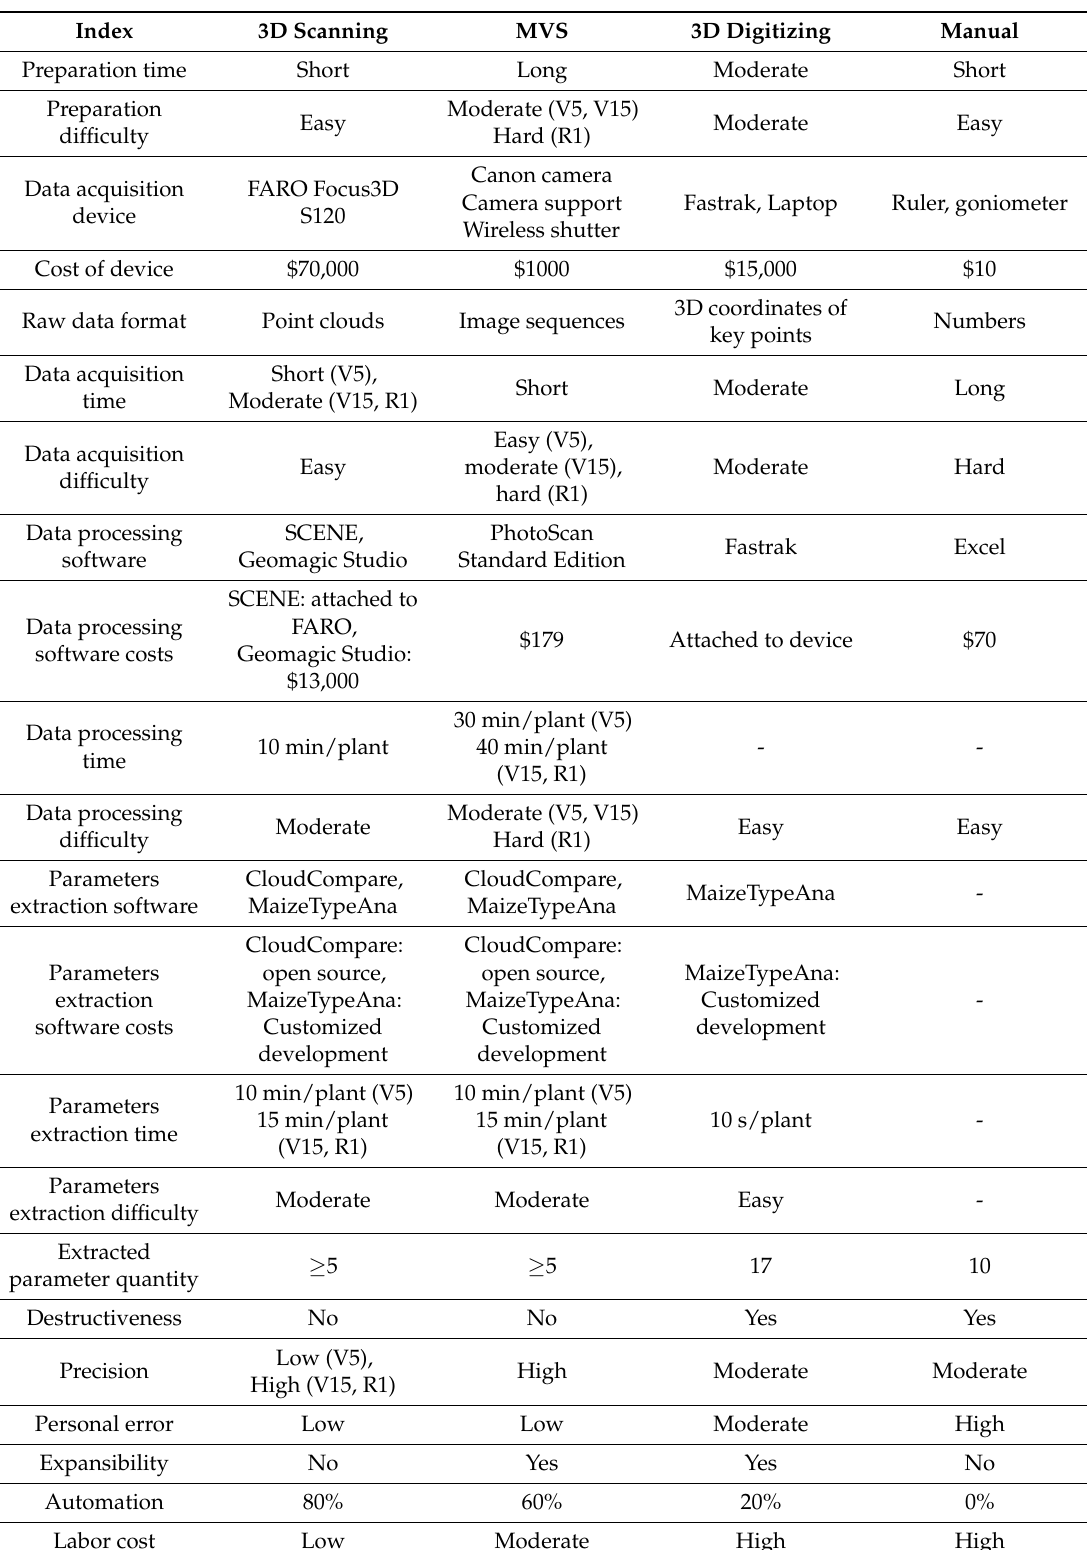
Table 2. Comparative analysis of different phenotyping approaches for maize